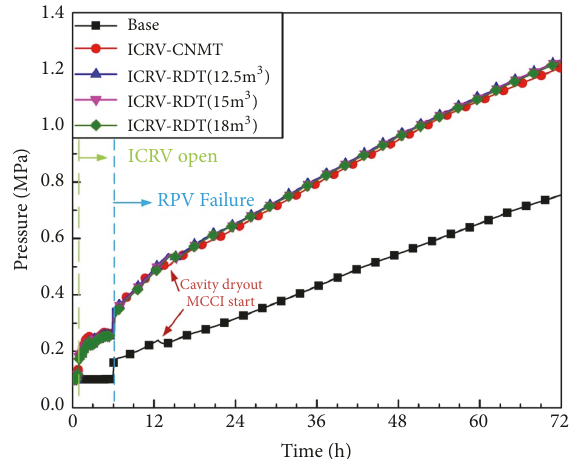
Figure 14: Comparison of containment pressure with the base case, the ICRV-CNMT case, and the ICRV-RDT